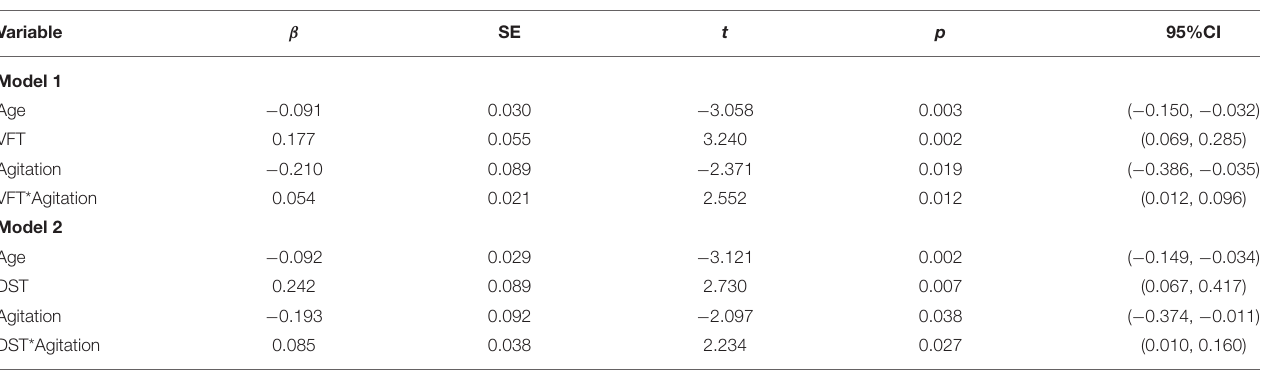
TABLE 3 | Multiple linear regression analysis of the potential impact factors on OI with